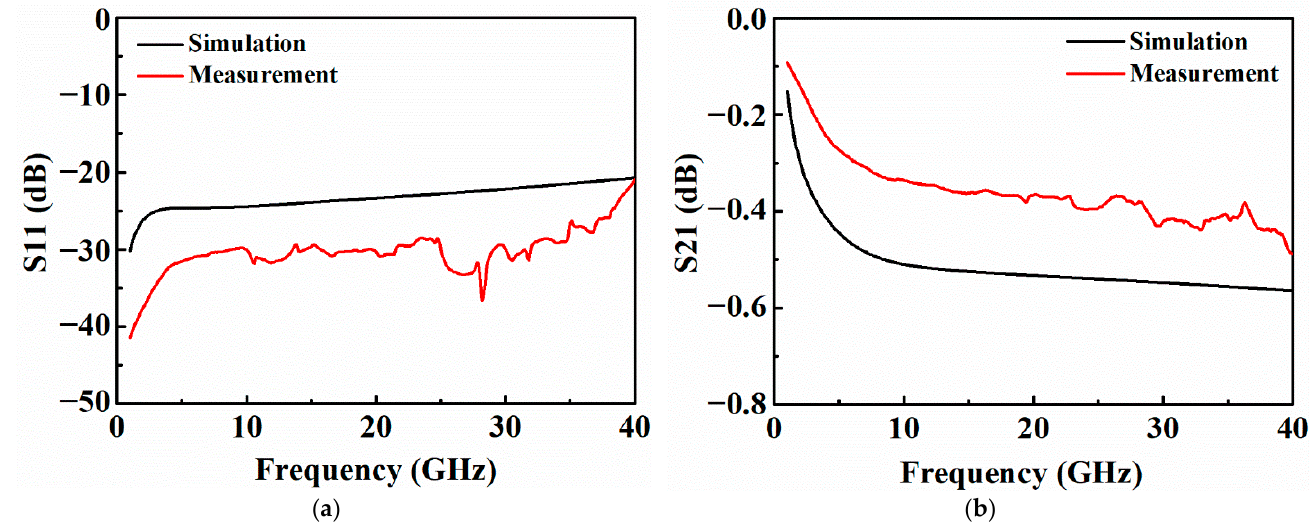
Figure 15. Comparison of the S-parameters of a single TSV between simulation and measurement: ( a ) return loss (S11), ( b ) insertion loss (S21).